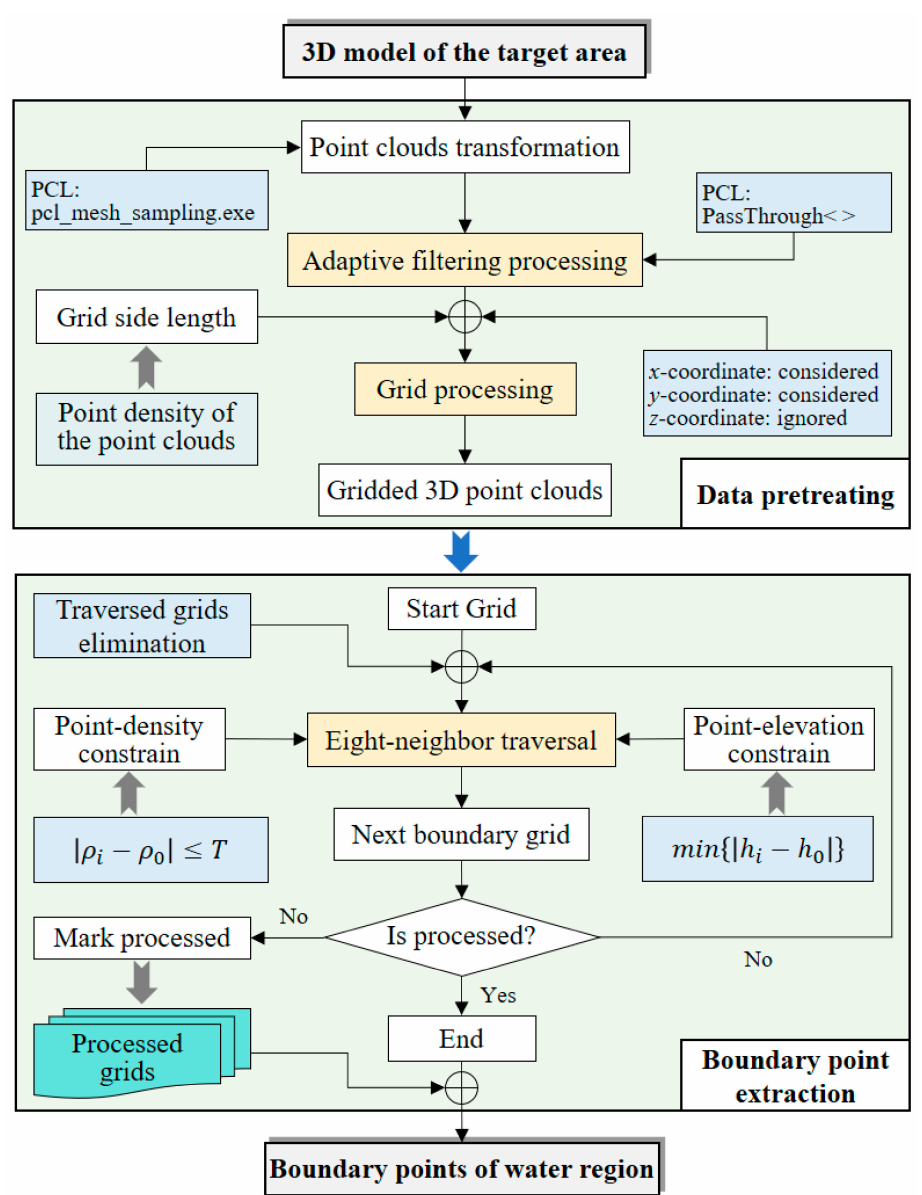
Figure 2. The flowchart of the procedure of boundary point extraction of water